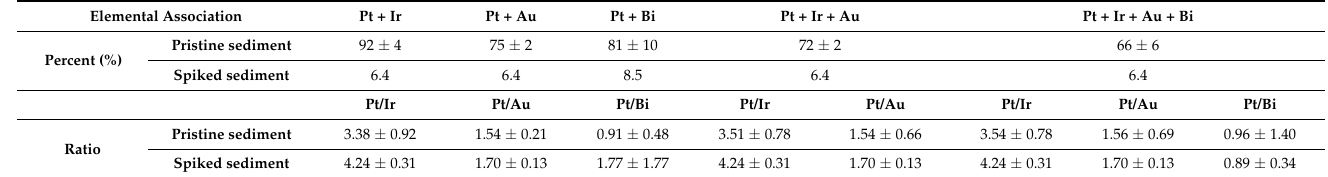
Figure 2. ( a ) Pt ‐ containing NP elemental compositions and ( b ) mass ratio of Pt to other elements in the Pt ‐ containing NPs in the unspiked/pristine sediment sample. The NPs were extracted by physical one ‐ step extraction, dispersed in FL70, and acquired over a period of 2 min out of 10 min. The x ‐ axis indicates the elemental composition of each particle represented. Pt is marked in blue and Ir, Au, and Bi in red to facilitate their perception. Table 1. Proportions of Pt ‐ containing NPs comprising Ir, Au, and Bi from the total 90 Pt ‐ containing NPs detected and the average elemental ratios within the particles in the pristine sediment sample and the Pt ‐ spiked sediment sample (Phys1 ‐ LKSD ‐ Spiked ‐ FL70 ‐ 1). The NPs were extracted by physical one ‐ step extraction, dispersed in FL70, and acquired over a period of 10 min.